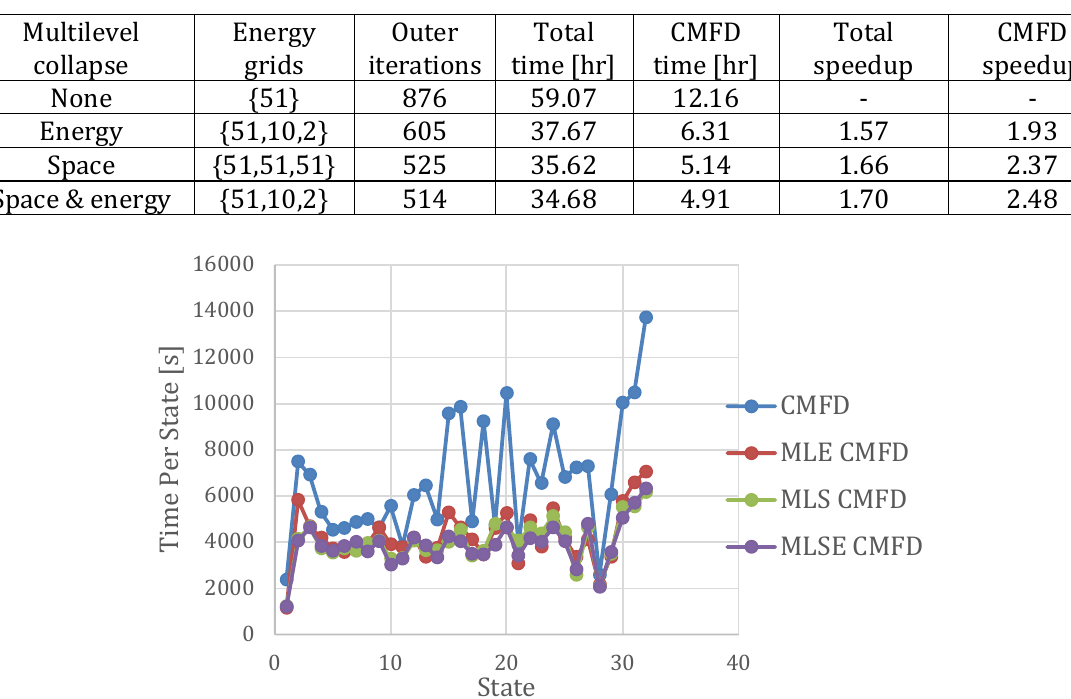
Figure 5. Time per depletion state point p9 Cycle 1.